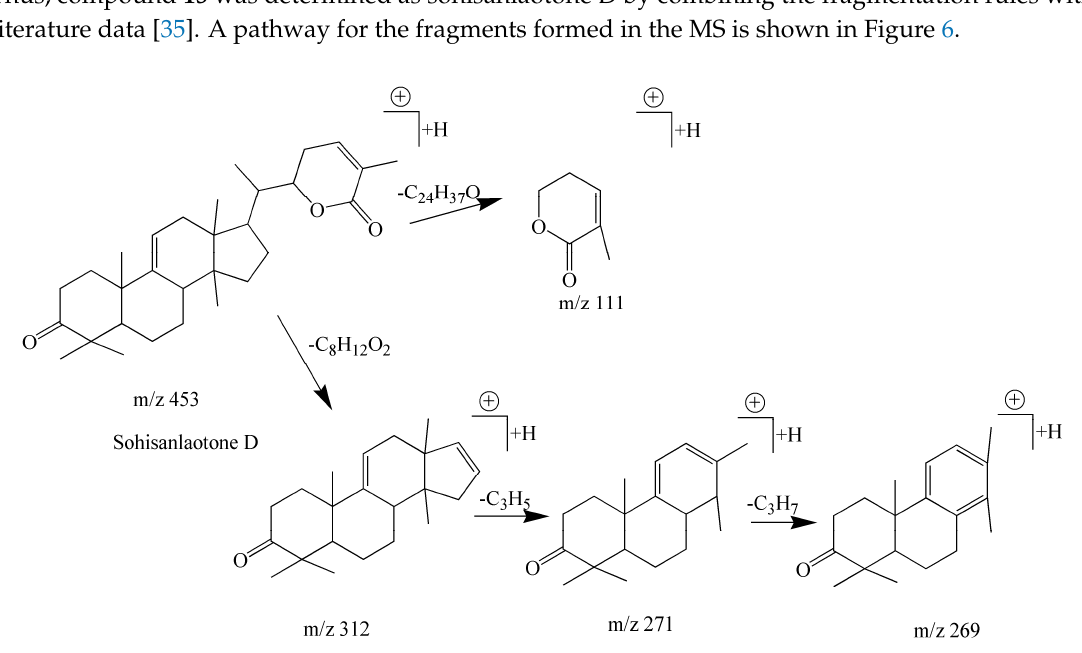
Figure 6. A fragmentation pathway of sohisanlaotone D in positive ion mode.